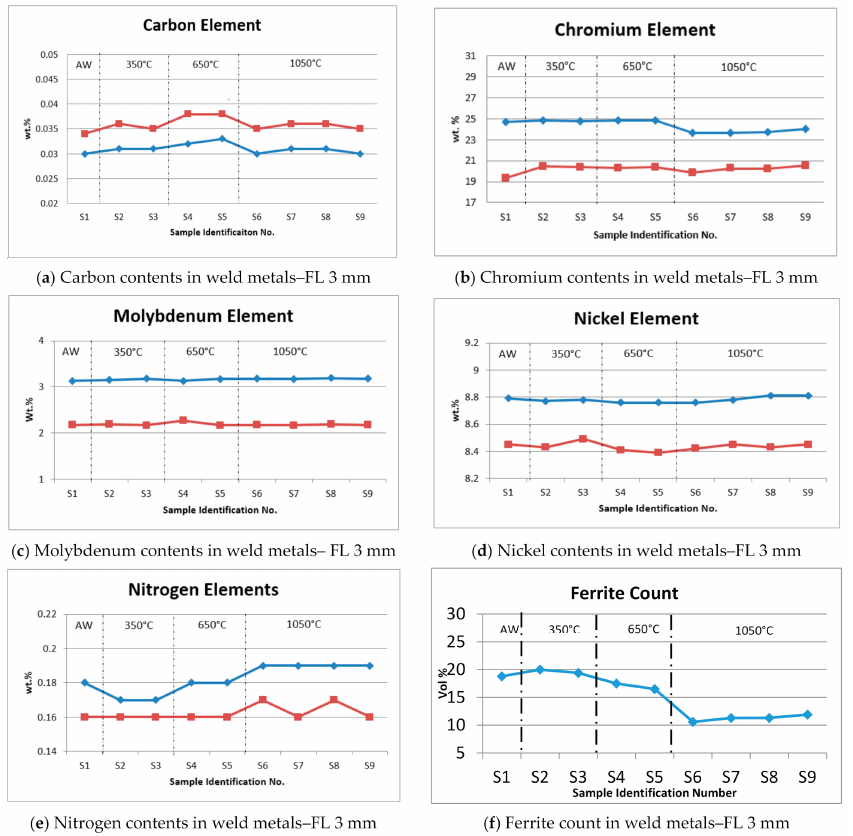
Figure 5. Chemical elements and ferrite counts for as-welded and heat treated